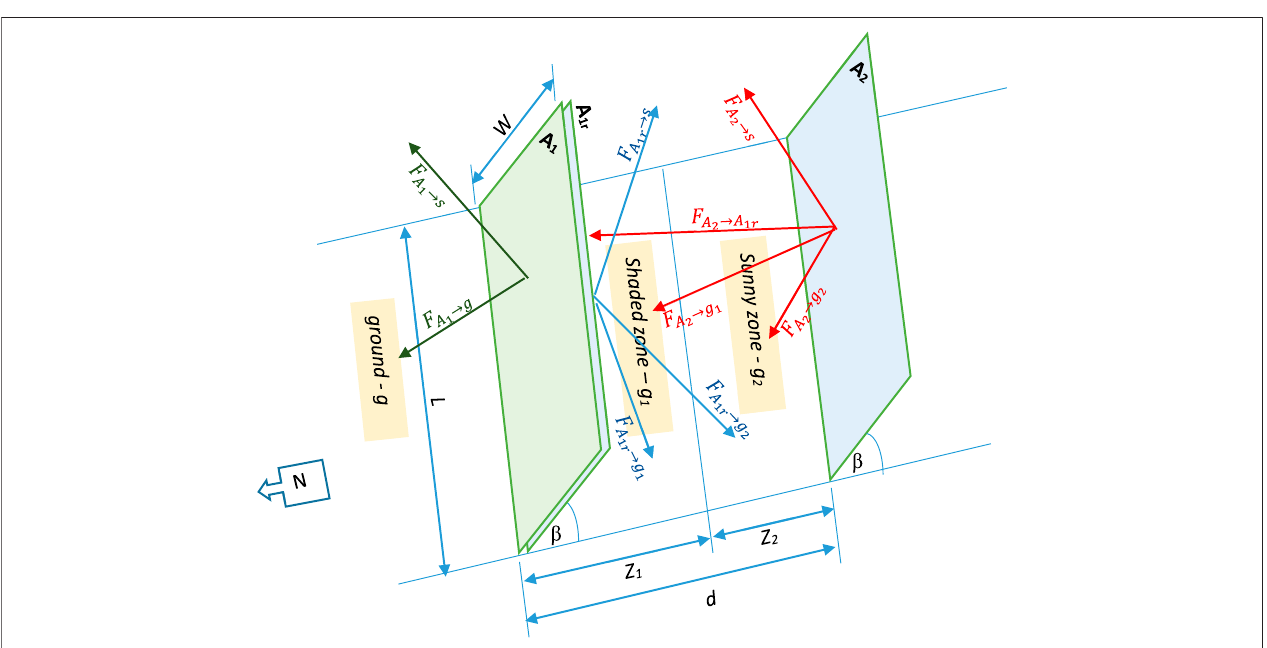
FIGURE 2 | View factors of a horizontal plane solar PV fi eld at an instant of